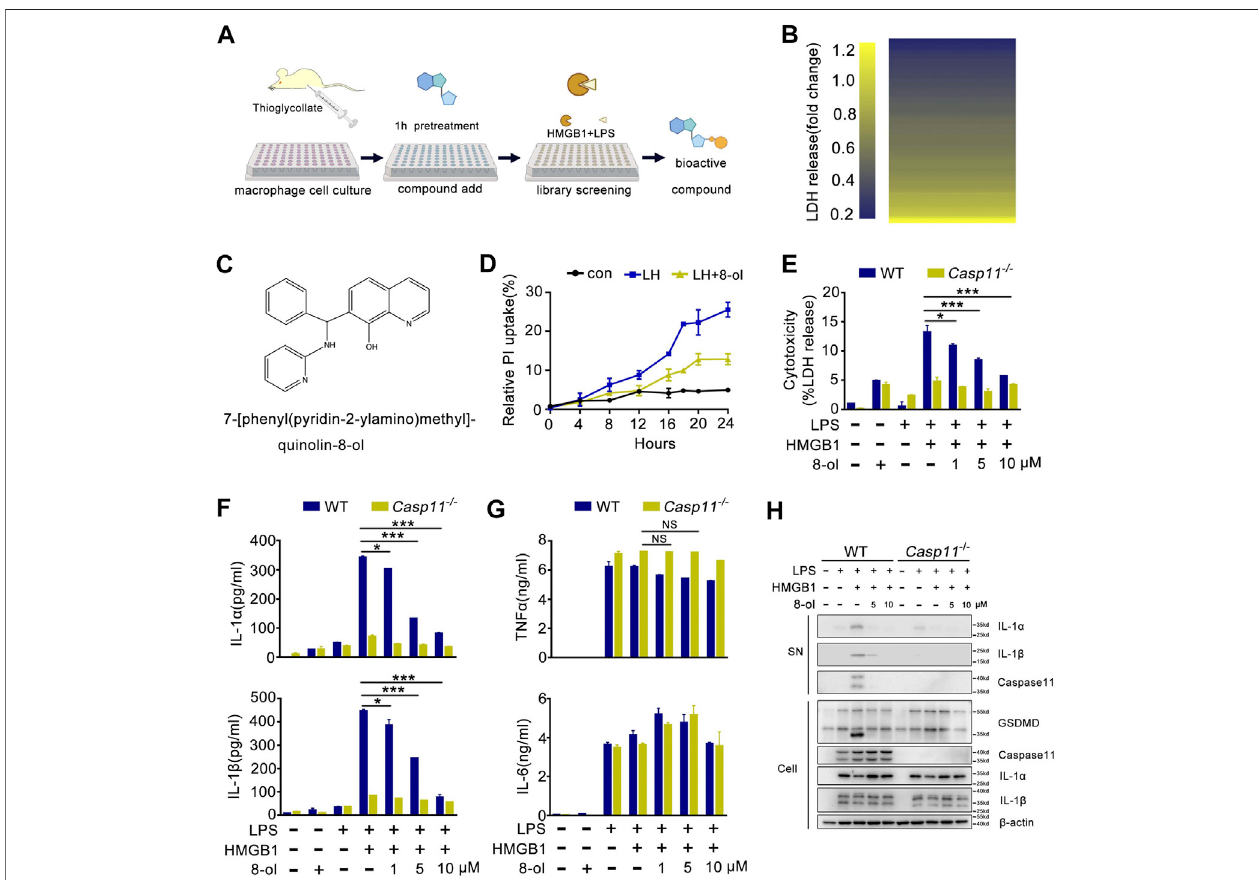
FIGURE 1 | Phenotypic screening system identi fi ed that 8-ol speci fi cally inhibits HMGB1-mediated caspase-11 signaling in vitro . (A) Schematics of the screening steps from compound libraryin mouse macrophage stimulated withrecombinantHMGB1 plus LPS. (B) Heat map ofLDH release changesinmacrophagesexposed to both recombinant HMGB1 (400 ng/ml) and LPS (1 μ g/ml) for 16 h with 102 bioactive compounds (10 μ M). (C) Chemical structure of 7-[phenyl (pyridin-2-ylamino) methyl] quinolin-8-ol. (D) PI uptake in a time-dependent manner in mouse macrophage stimulated with recombinant HMGB1 (400 ng/ml) and LPS (1 μ g/ml) in the absence or presence of 8-ol (2 μ M). (E – G) LDH and cytokine (IL-1 α , IL-1 β , TNF α , and IL-6) release from WT or Casp11 − / − peritoneal macrophages stimulated with HMGB1 (400 ng/ml) plus LPS (1 μ g/ml) for 16 h in the absence or presence of 8-ol of indicated dose. (H) Western blots for IL-1 α , IL-1 β , and caspase-11 in the supernatant or the cleavage of GSDMD and the expression of IL-1 α , IL-1 β , and caspase-11 in the cell lysates of WT or Casp11 − / − peritoneal macrophages stimulated with HMGB1 (400 ng/ml) plus LPS(1 μ g/ml) in the absence or presence of 8-ol for 16 h. Graphs show the mean ± SD of technical replicates and are representative of at least three independent experiments. * p < 0.05; ** p < 0.01; *** p < 0.001, NS: not signi fi